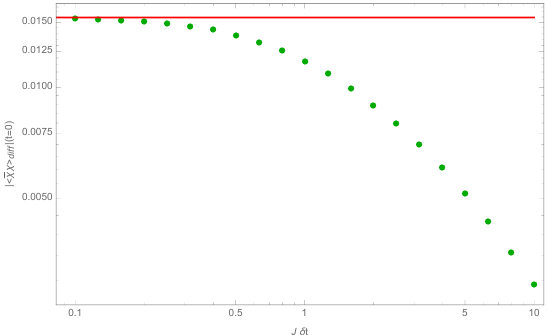
Figure 10 . Plot of h (cid:22) (cid:31)(cid:31) i di(cid:11) at t = 0 as a function of J(cid:14)t for the gapped-interior quench shown in the inset. At the beginning of the quench g ( t = (cid:0)1 ) = 1 : 01 and we measure at g ( t = 0) = 0 : 9. The red line is the result (4.23) for instantaneous quenches evaluated using eq. (4.24), which in this case yields 0 :